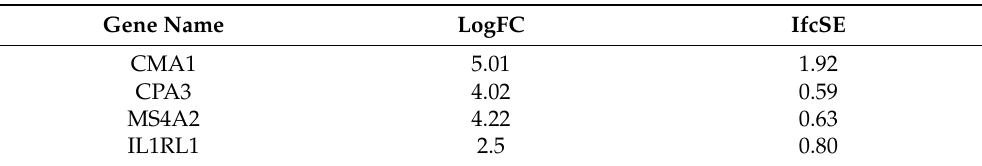
Table 2. Prominently up-regulated genes in the osteophyte samples; patient to patient variation revealed by these mast cell-specific markers in the transcriptome analysis, wherein LogFC showed the difference of the gene expression between OA cases and controls and IfcSE was a standard deviation of the